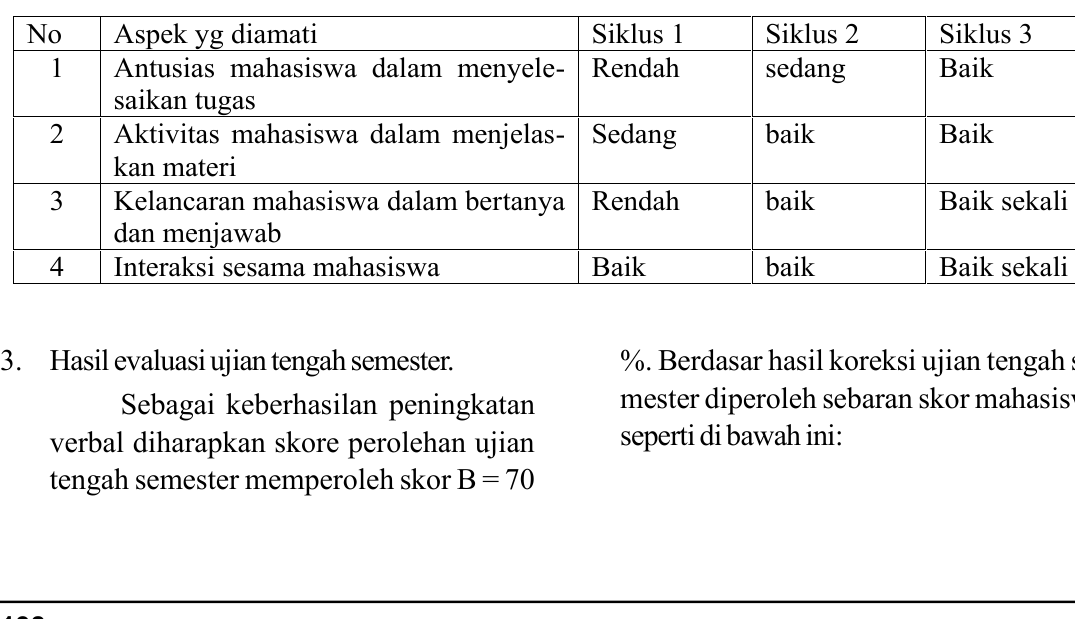
Profesi Pendidikan Dasar, Vol. 2, No. 1, Desember 2014: 132-140 138